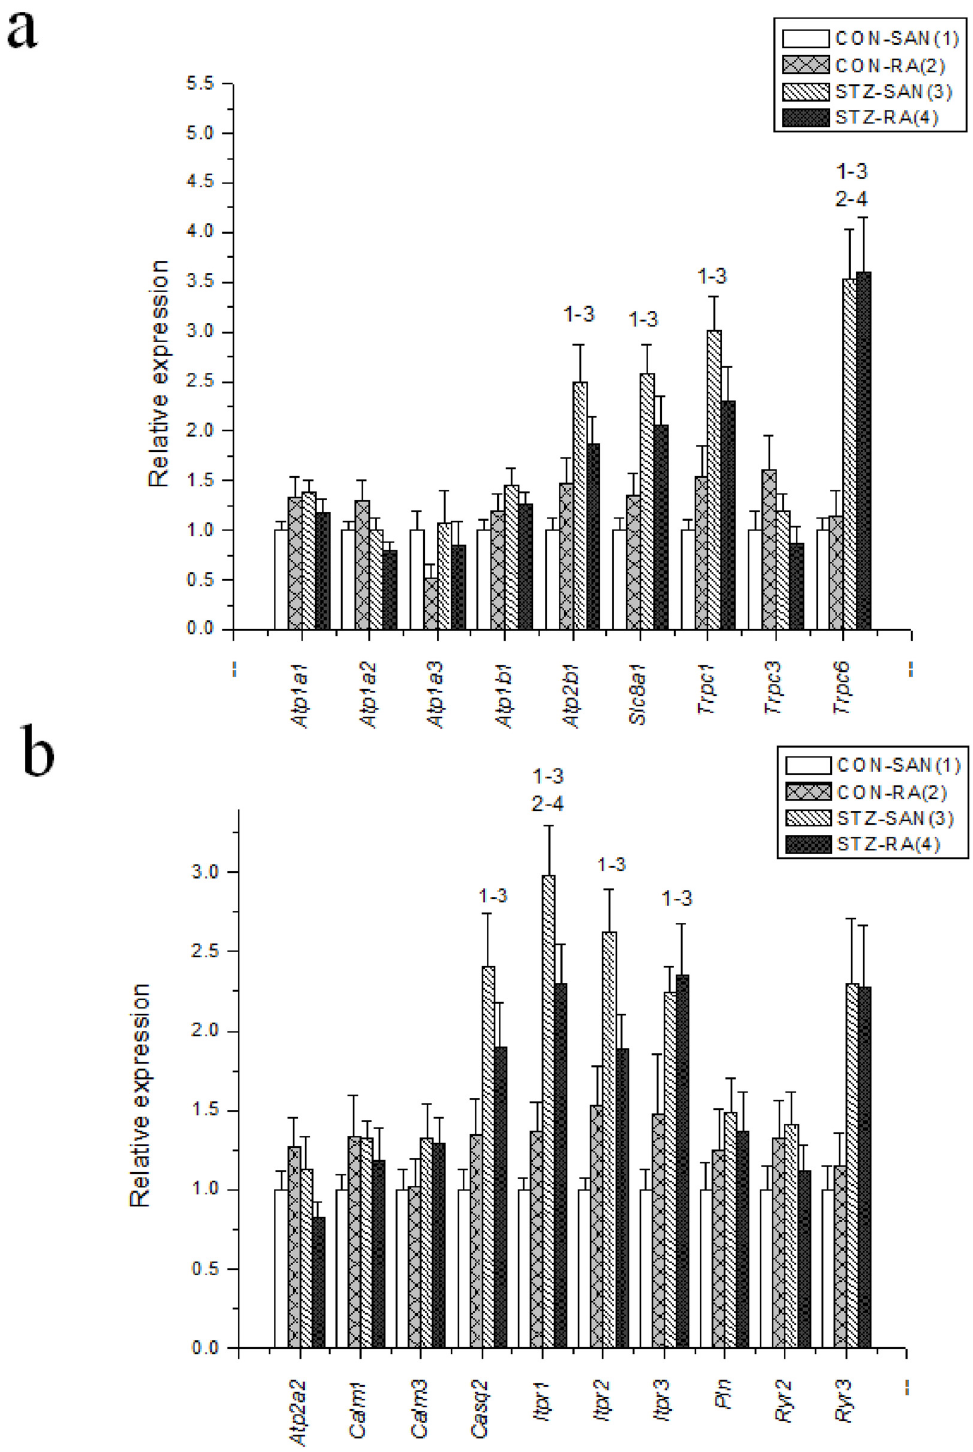
Fig 5. (a) Expression of genes encoding various intracellular Ca 2+- transport and regulatory proteins and (b) membrane transport proteins. Data are mean ± SEM, n = 6 – 10 samples from STZ and control rat each containing SANs from 2 hearts.